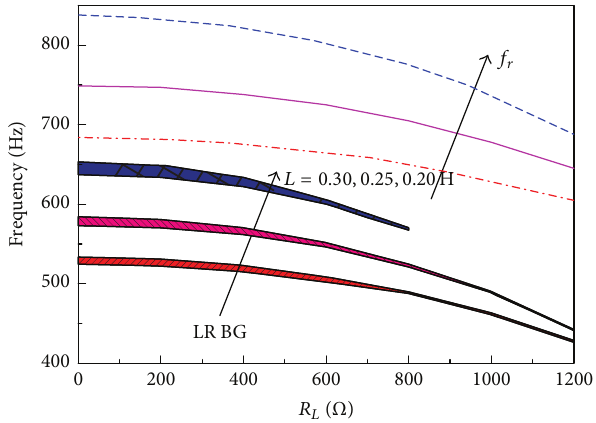
Figure 10: Band structure of the two-dimensional PPC-C of hexagonal